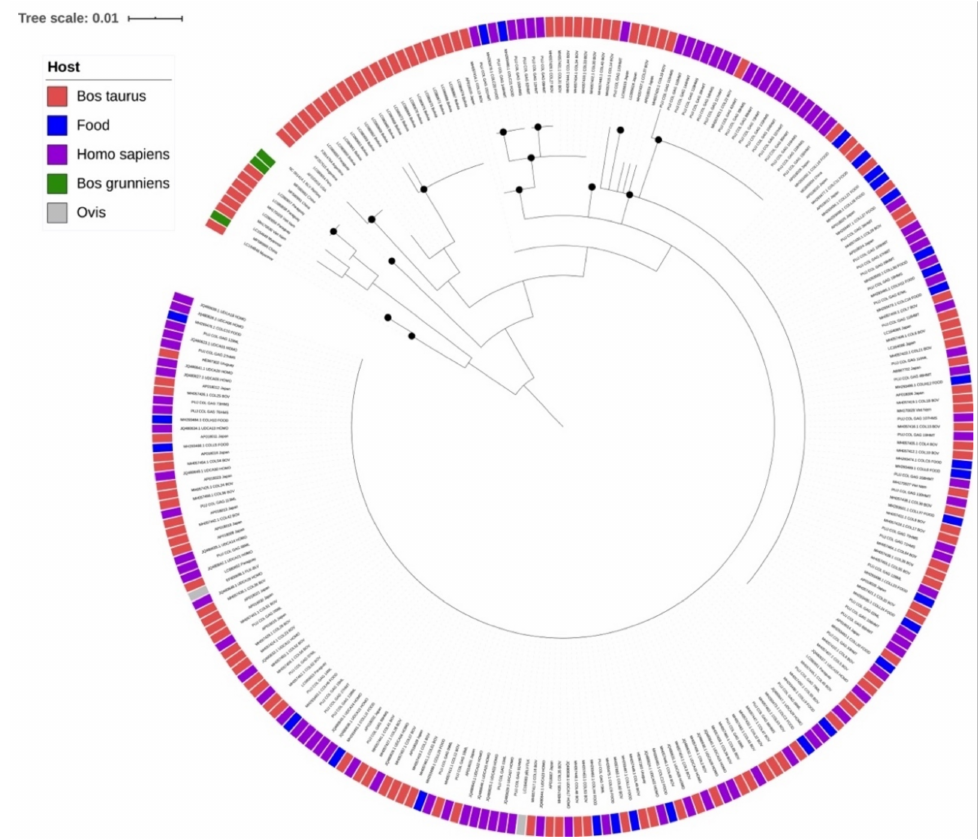
Figure 1. IQ-TREE phylogenetic reconstruction obtained from the multiple alignment performed in MAFFT of the complete data set (GenBank reference sequences and Colombian sequences). A region of 182 pb of the gag gene is shown. Colors indicate source of the virus. Red—bovine, Blue—food, Purple—humans. Jukes–Cantor substitution model was used in IQ-TREE. Black dots represent nodes higher than 90%, with a bootstrap of 1000